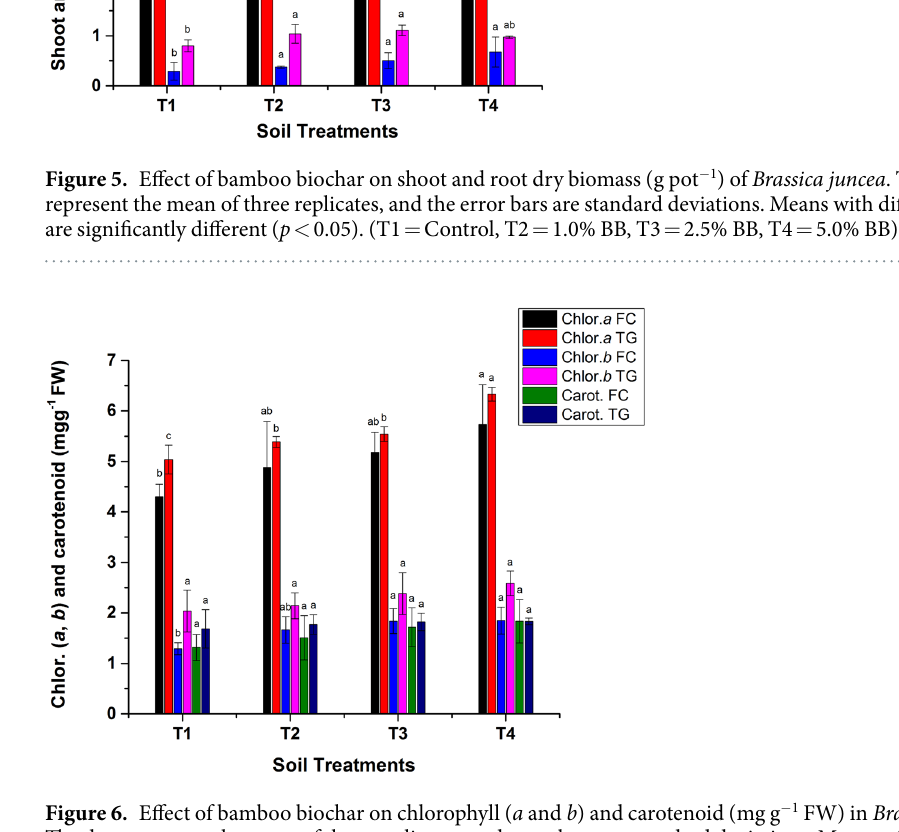
Figure 6. Effect of bamboo biochar on chlorophyll ( a and b ) and carotenoid (mg g − 1 FW) in Brassica juncea . The data represent the mean of three replicates, and error bars are standard deviations. Means with different letters are significantly different ( p < 0.05). (T1 = Control, T2 = 1.0% BB, T3 = 2.5% BB, T4 = 5.0%